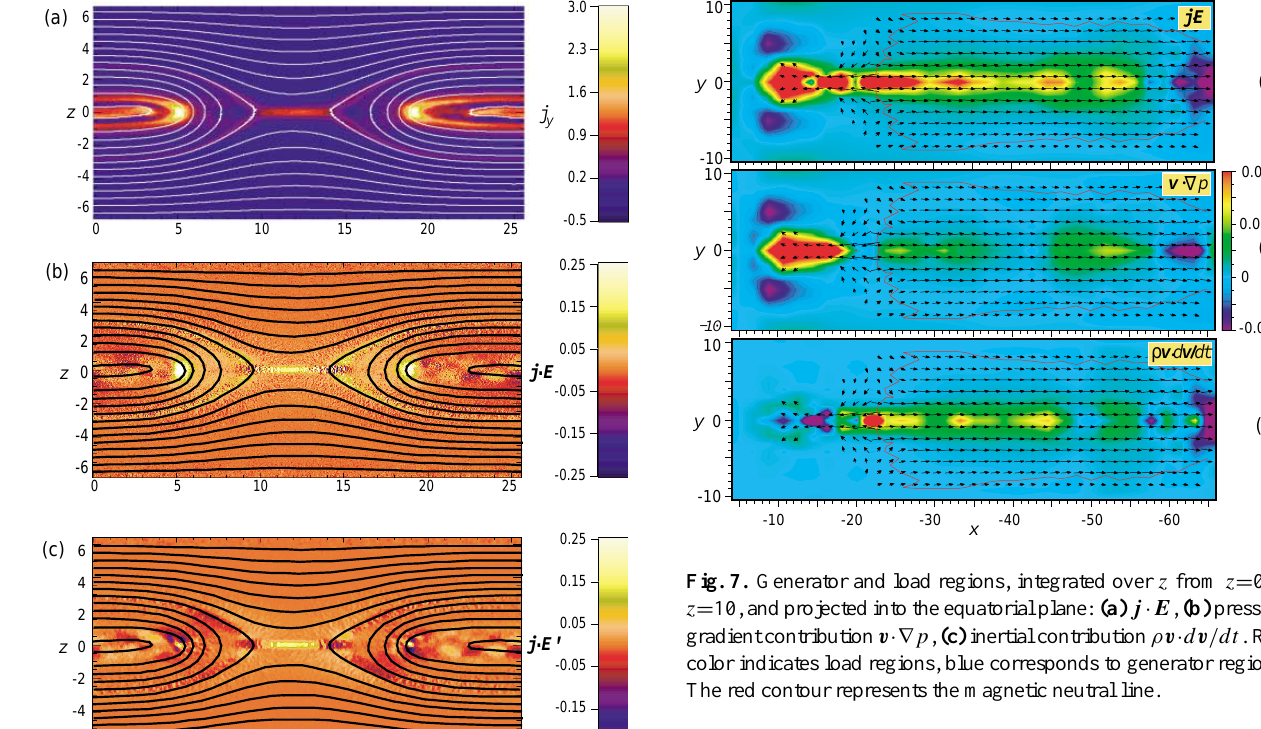
of generator regions and current diversion rely on the force balance, Eq. (8). We note, however, that the generator evalu- ation takes only the components of the forces in the direction of the flow into account. The dominant contribution to j · E stems from the pres- sure gradient term in Eq. (12). This is illustrated by Figs. 7b and c, showing the pressure gradient and the inertial contri- bution, respectively, as function of x and y , again integrated over z . The inertia term provides a generator mechanism in the region of flow braking, as postulated by Shiokawa et al. (1997). In the integral evaluation, however, this term is over- compensated by a load term from the pressure contribution, located at higher | z | (Fig. 5a). Details of the generation regions and mechanisms in the near tail at | y |≈ 5 are demonstrated by Fig. 8 for a tail cross- section at x =− 8 . 75, showing (a) j · E , (b) ∇· S , (c) v ·∇ p , (d) ∇ · H where H = (u + p) v is the enthalpy flux, (e) the cross- tail current density j y , and (f) the earthward flow velocity component v x . Note that the color scale in Fig. 8d differs from those in Figs. 8a–c. Solid lines represent the bound- aries of the closed field line region (separatrices), and arrows show the projection of velocity vectors perpendicular to the magnetic field. Figure 8a demonstrates that the generator re- gions (blue) near | y |= 5 are located not in the equatorial plane but away from it; this is consistent with the current diversion found earlier (Birn and Hesse, 1996; Birn et al., 1999). The generator regions are part of a vortical flow pattern, which is also associated with the build-up of the field-aligned cur- rents of the substorm current wedge. The energy stems from mechanical work that is done by flow toward the lobes in the direction of the pressure gradient force ( v · ∇ p< 0; Fig.